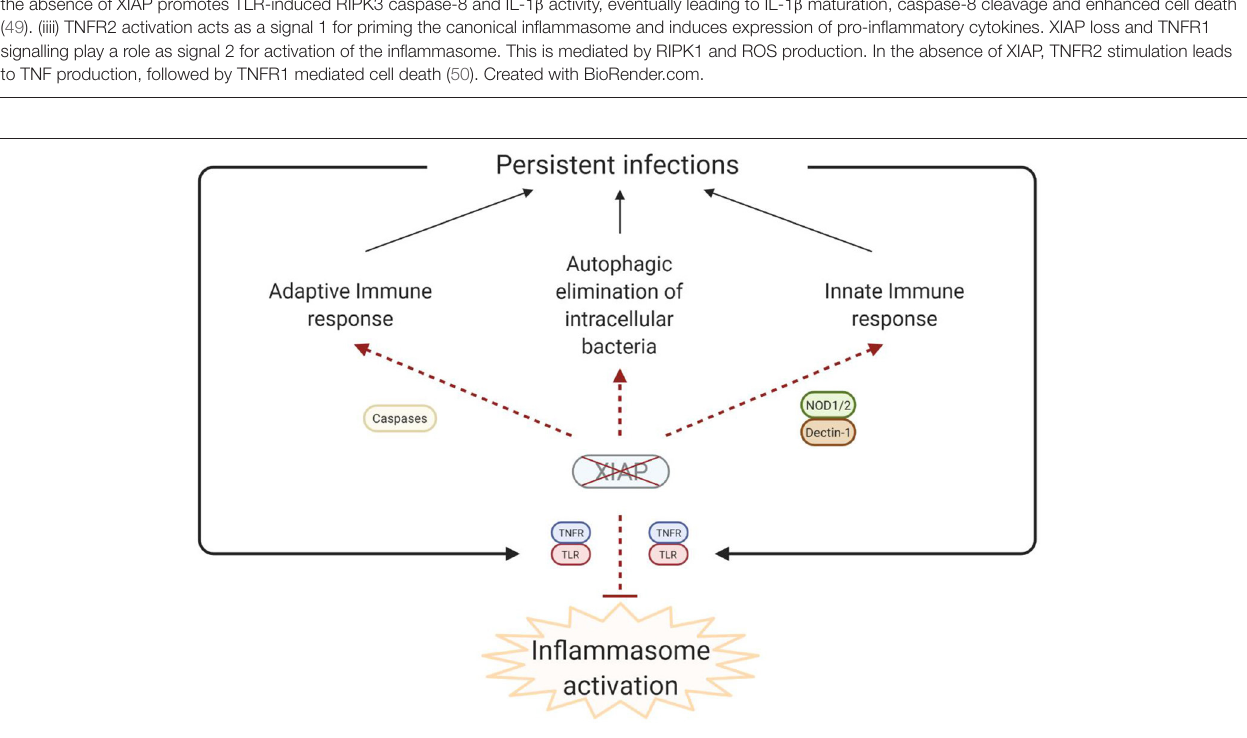
FIGURE 4 | Simplified model of the disease pathophysiology underlying the inflammatory phenomena that are observed in XIAP deficiency. In XIAP deficiency, both the adaptive immune response and the innate immune response are compromised. Additionally, intracellular pathogens are less effectively cleared through xenophagy in the absence of XIAP. Taken together, this results in the persistence of pathogens, which, in turn leads to uncontrolled activation of inflammasomes when regulation by XIAP is lacking. Overall, the result is overproduction of pro-inflammatory cytokines and cell death, leading to a chronic state of hyperinflammation, which can manifest as HLH, IBD, HLH-like disease, arthritis and other inflammatory phenomena. Created with